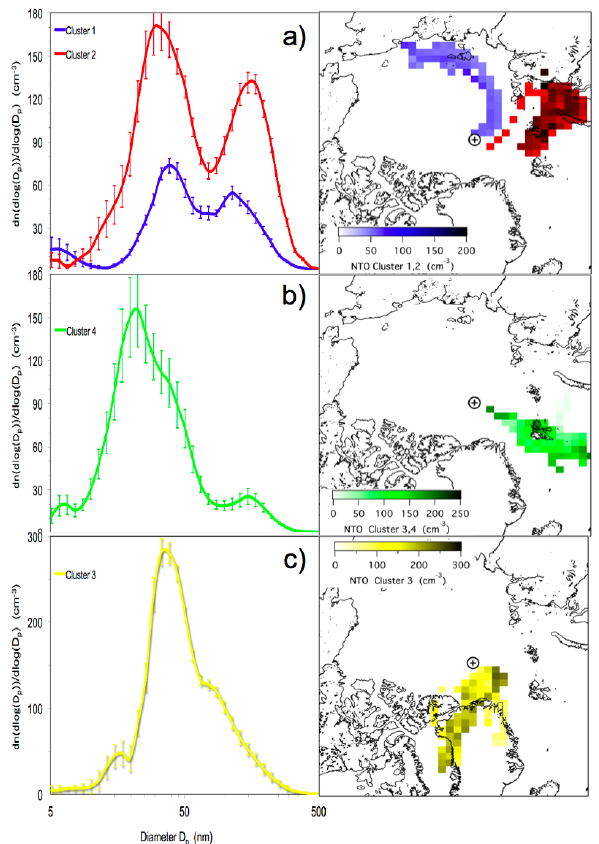
Figure 7. Left: average particle number size distributions of the four clusters of horizontal trajectory coordinates, combined with particle size distributions in the marginal ice subpopulation. The clusters are separated into (a) marine, (b) Spitsbergen, and (c) Greenland. Error bars show 1 standard deviation about the group average. Blue shows cluster 1; yellow shows cluster 3; green shows cluster 4. Right: cor- responding regional distributions of median total number concentra- tions (NTO, cm − 3 ) . The color saturation indicates the total number associated with the respective trajectory. Only geocells with at least 25 trajectory hits are shown. The plus symbol indicates the North Pole.